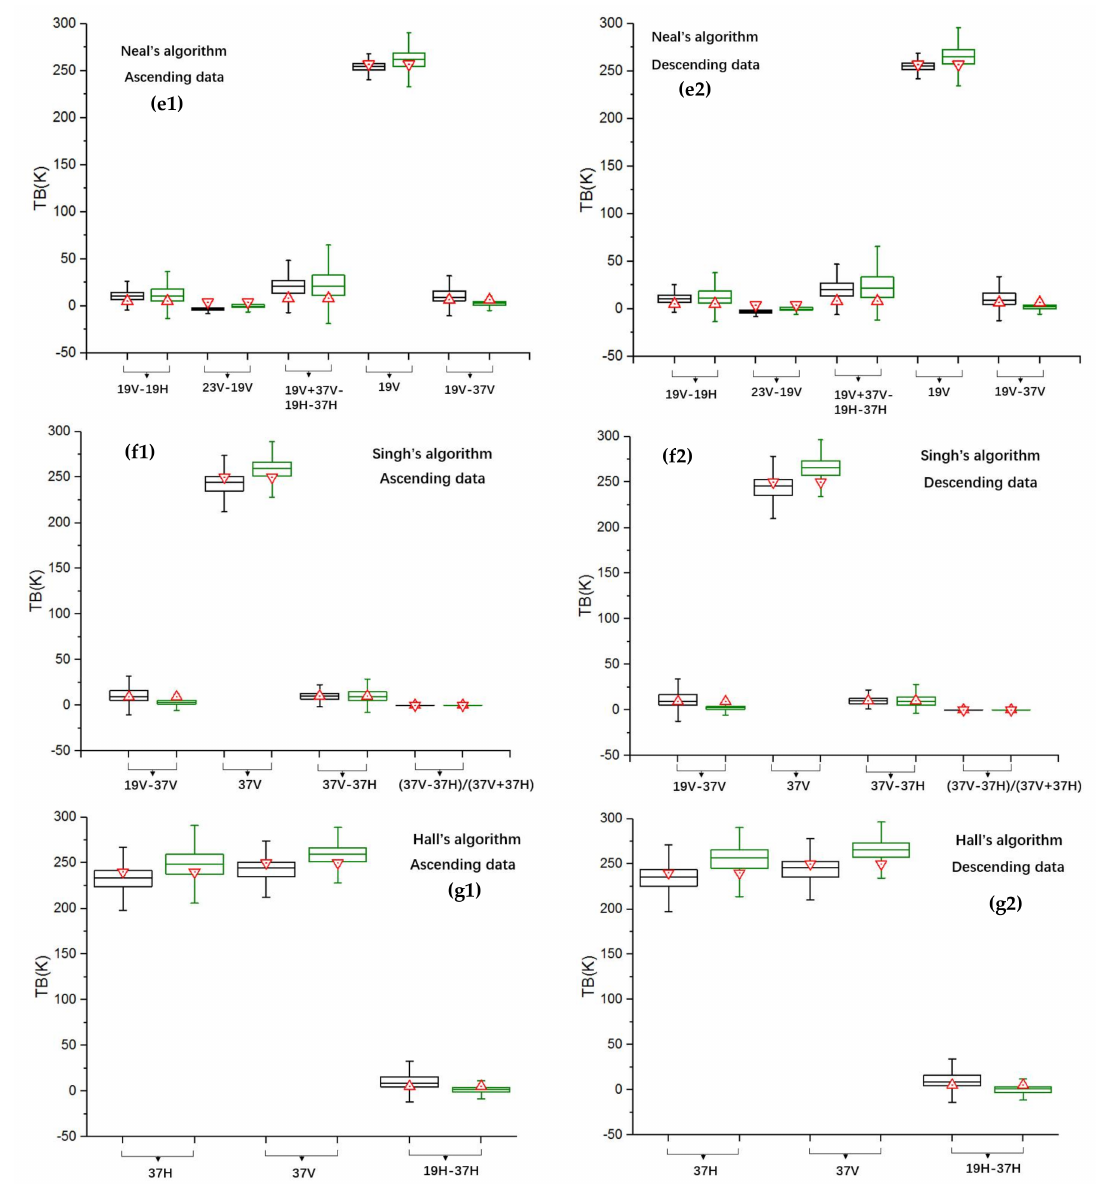
Figure 11. Box plots of Tb index values and thresholds of the seven PMW SCA mapping algorithms: Grody’s algorithm ( a1 , a2 ), Kelly’s SCA algorithm ( b1 , b2 ), the South China algorithm ( c1 – c3 ), FY SCA algorithm ( d1 , d2 ), Neal’s algorithm ( e1 , e2 ), Singh’s algorithm ( f1 , f2 ), Hall’s algorithm ( g1 , g2 ). (The up and down arrows indicate the lower bounds and upper bounds of the thresholds, respectively. Arrows in red and in blue indicate thresholds for snow identification and non-snow identification,